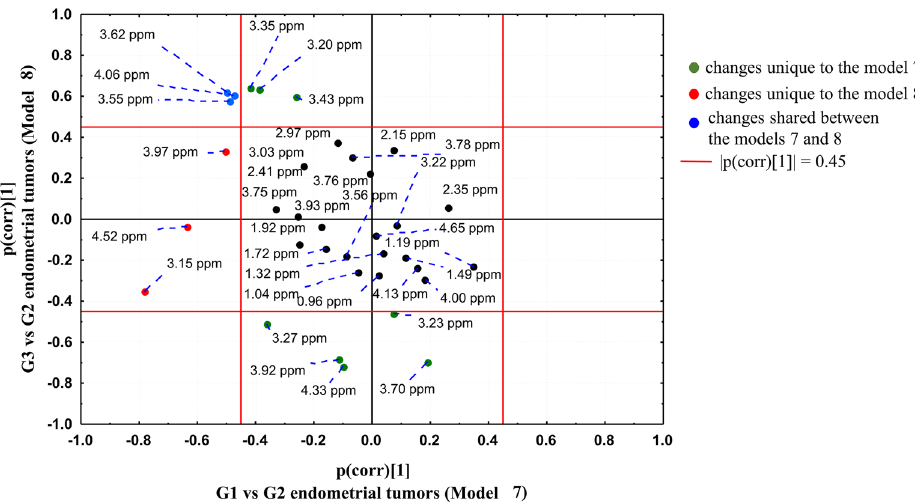
Figure 7. SUS plot comparing the OPLS-DA models 7 (discriminating the G1 and G2 tumors) and 9 (discriminating the G3 and G2 tumors). The image was created using Statistica 12.5 software (www. stats oft. pl).